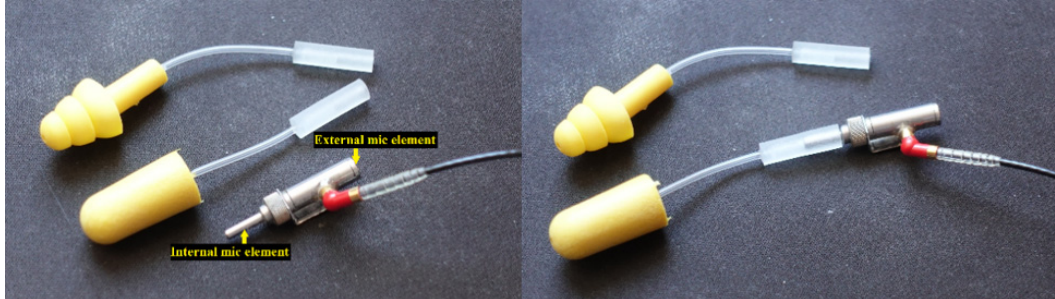
Figure 2. Schematic diagram for the measurement location in the evaluation of the attenuation of HPDs via the F-MIRE test method. Figure 2. The equipment used in the F-MIRE test method in this study.